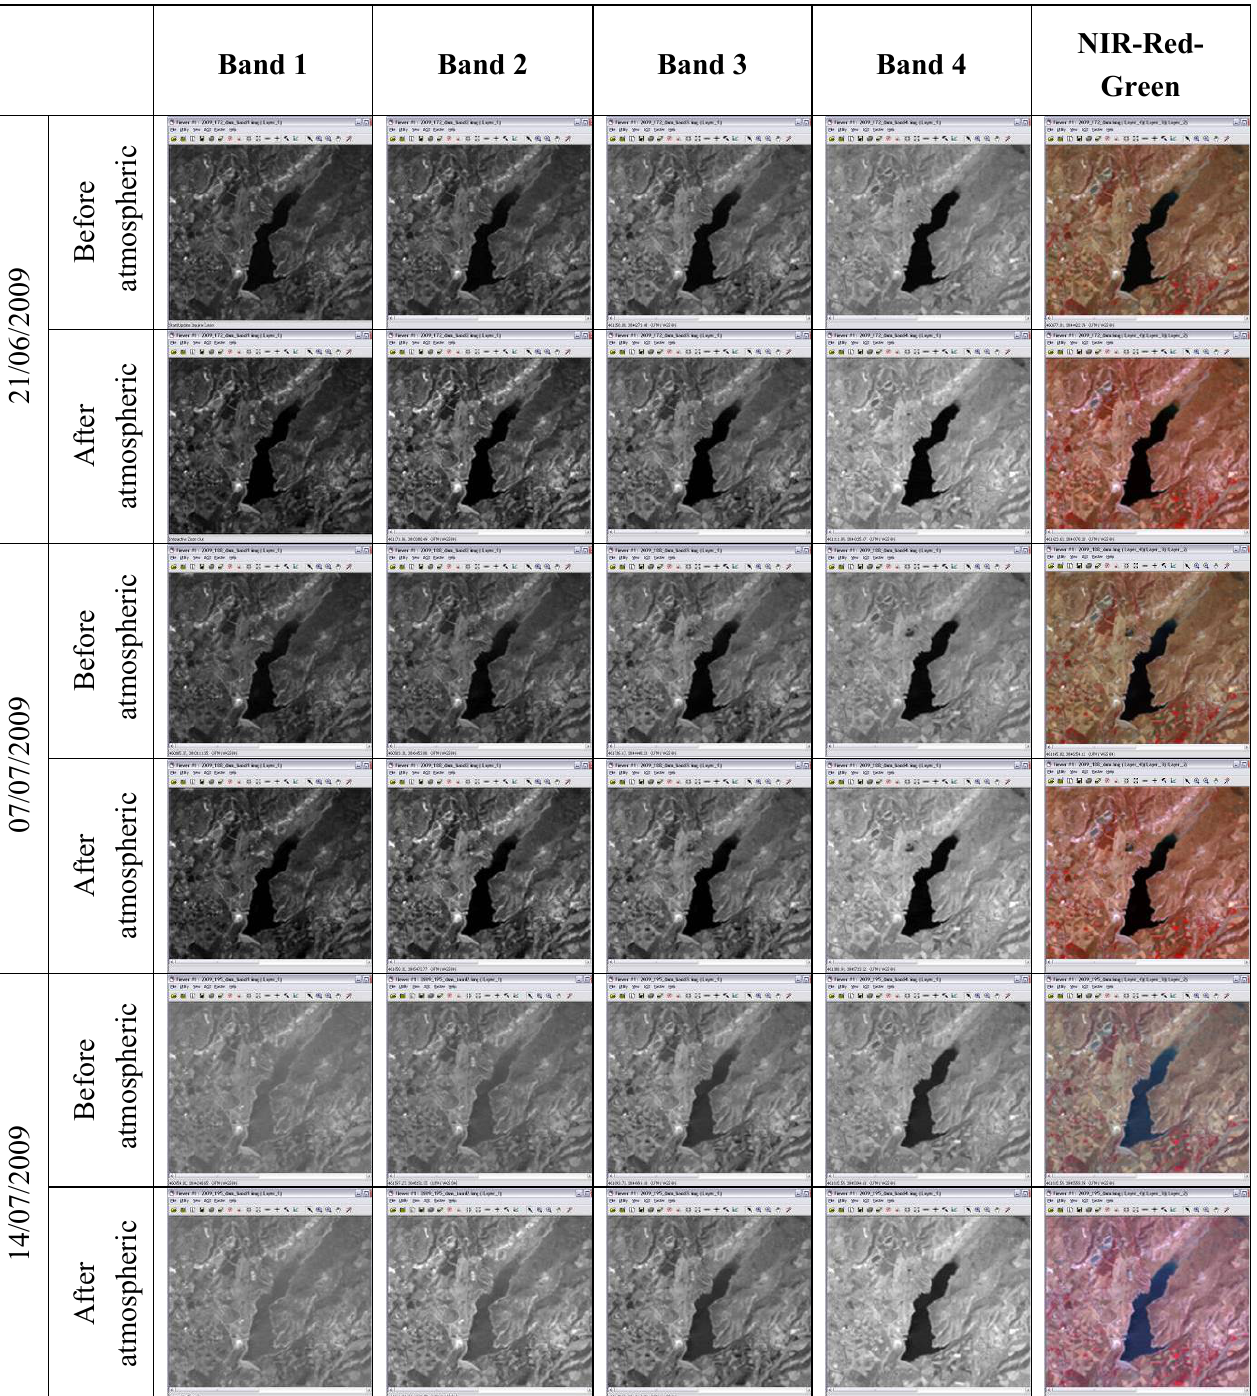
Table 6. Interpretation of the results before and after the atmospheric correction at the Asprokremmos